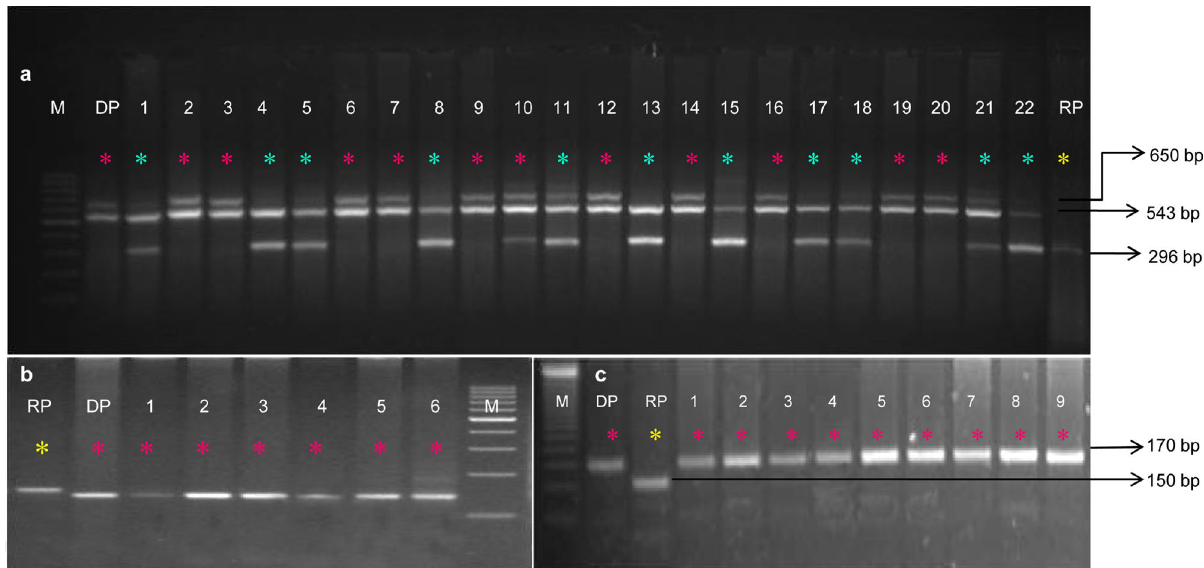
Figure 2. Foreground screening of BC 2 F 2 progenies using gene specific markers. ( a ), Multiplex PCR for selection of favorable alleles for crtRB1 and lcyE genes; ( b ), Amplification profile for selection of o2 gene using umc1066 SSR marker; ( c ), Amplification profile for selection of o2 gene using phi057 SSR marker. RP: recurrent parent; DP: donor parent; Red star indicates the desirable favorable alleles in homozygous condition; Yellow star indicates homozygous alleles to recurrent parent; Green star indicates both alleles present in heterozygous